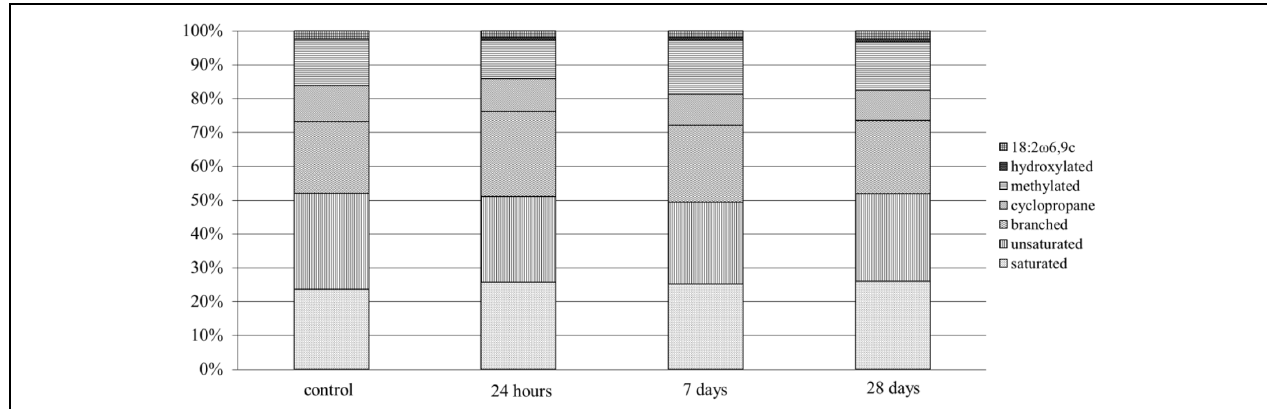
FIGURE 3 | Phospholipid fatty acid (PLFA) profiles derived from the non-inoculated control and soil inoculated with the MH8a strain.